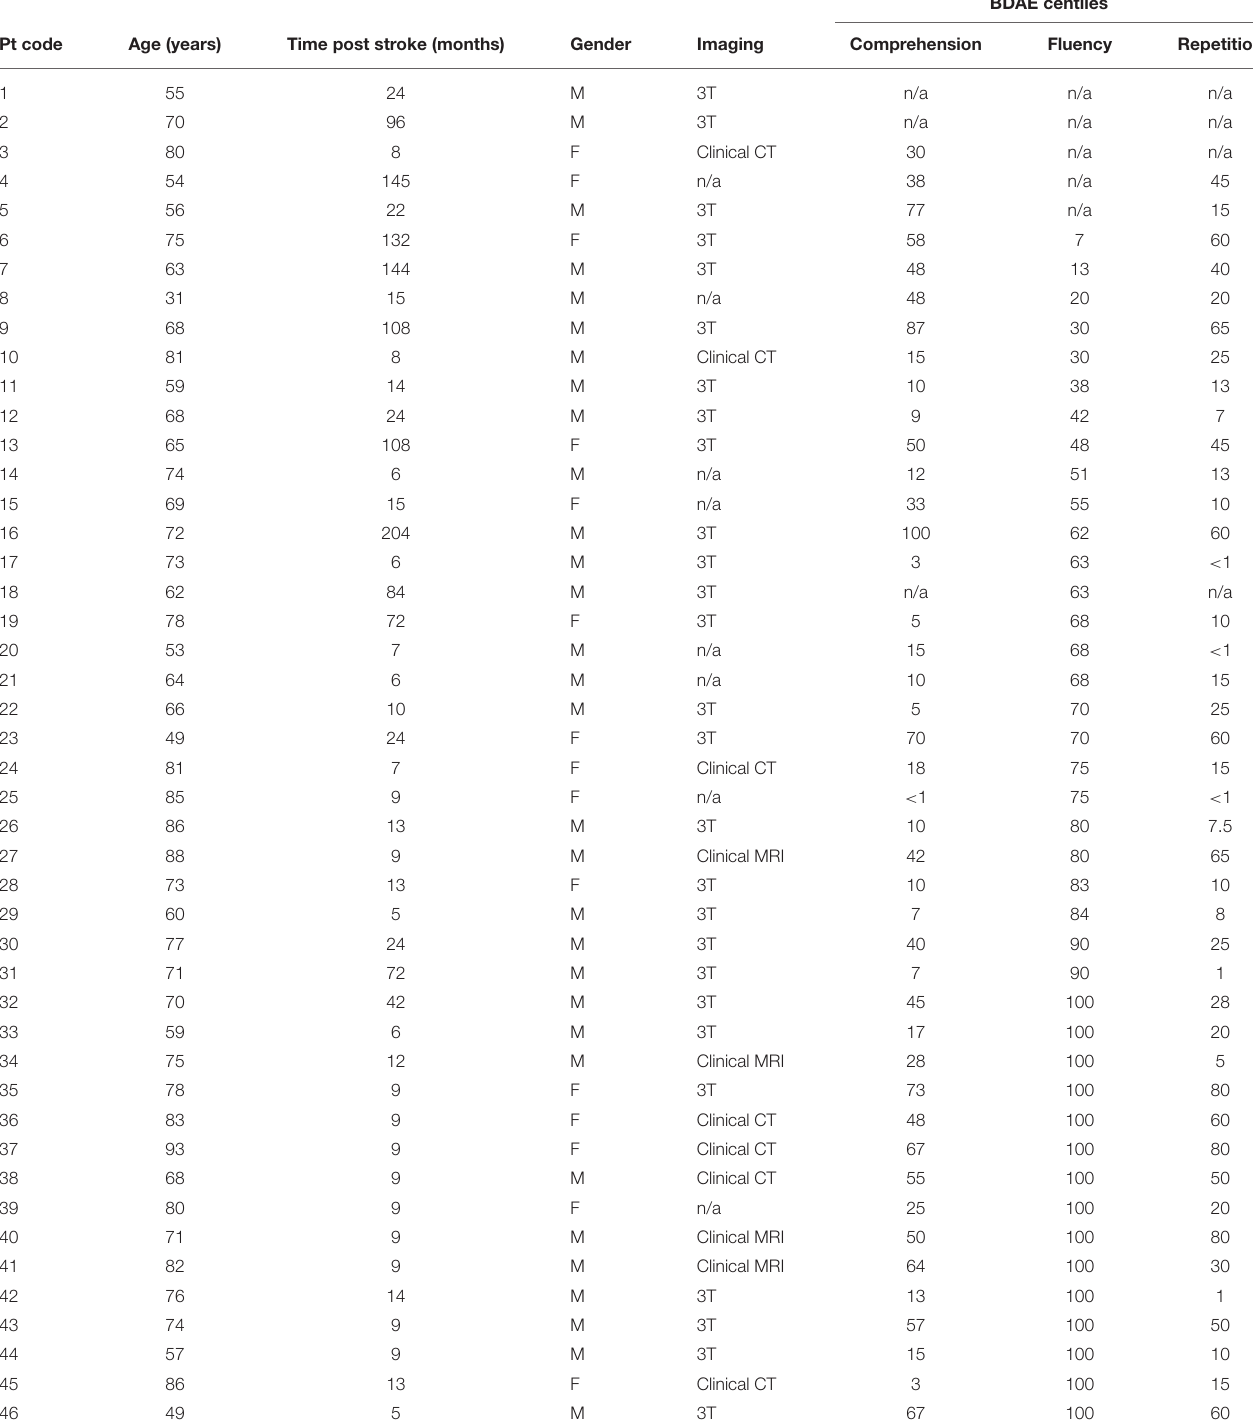
TABLE 1 | Demographic, imaging and BDAE